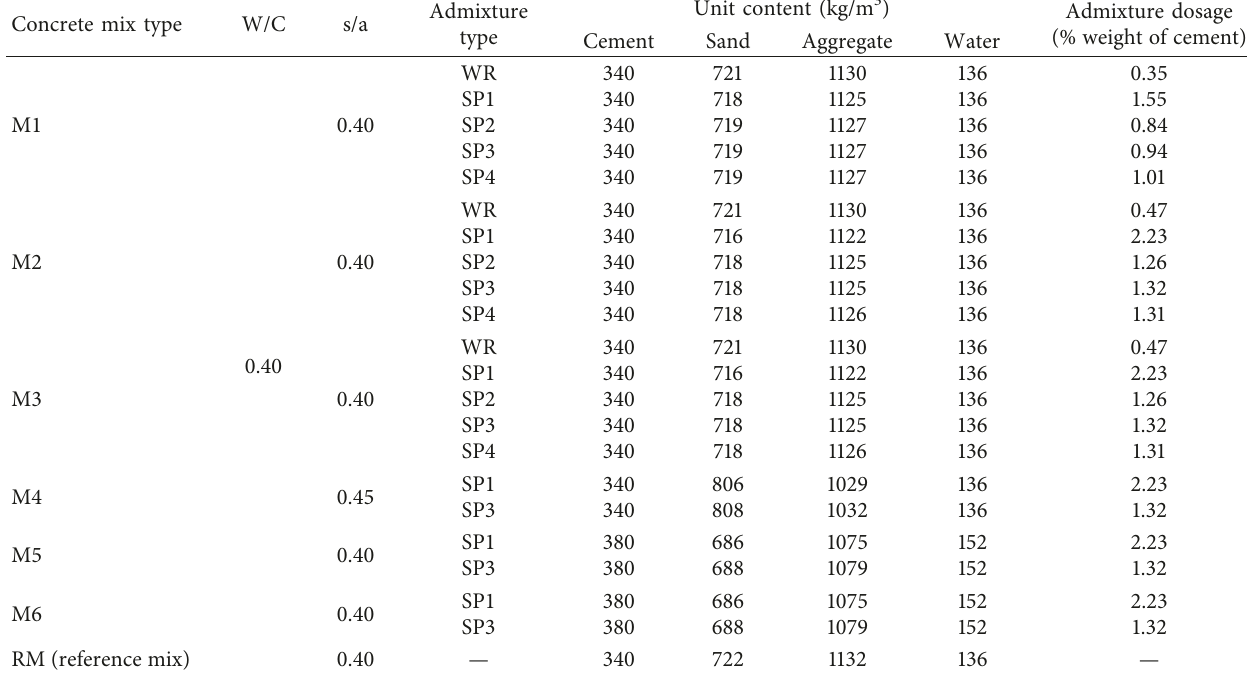
Table 5: Mixture proportion of